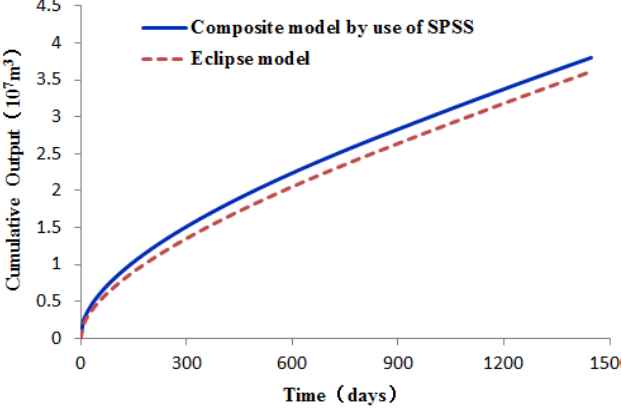
Figure 2. Comparison of cumulative gas production of model in this paper and the Eclipse numerical model.